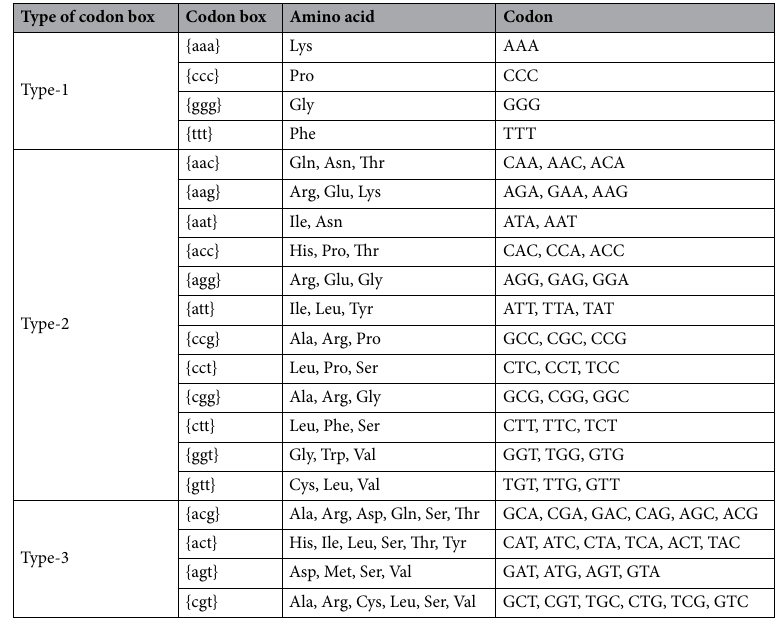
Table 1. Classification of codon boxes. According to the codon box concept, 64 codons can be divided into 20 kinds of codon boxes. Furthermore, the codon boxes can be classified into three categories: Type-1 has only one kind of base; Type-2 has two kinds of bases; and Type-3 has three kinds of bases.